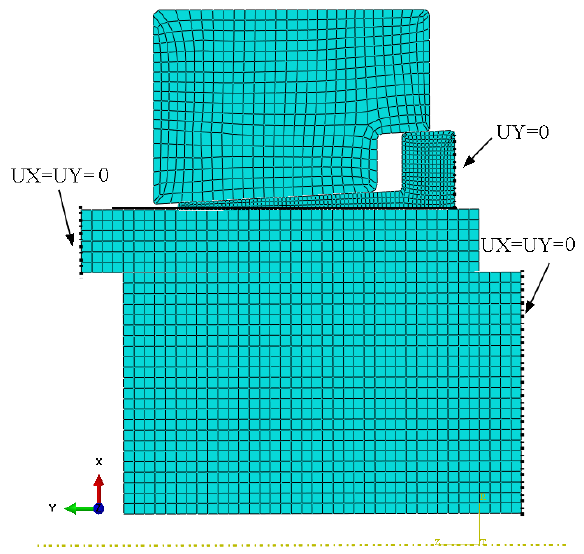
Figure 3. The boundary constraints and mesh distribution of the finite element model of the turbine shrink disk.